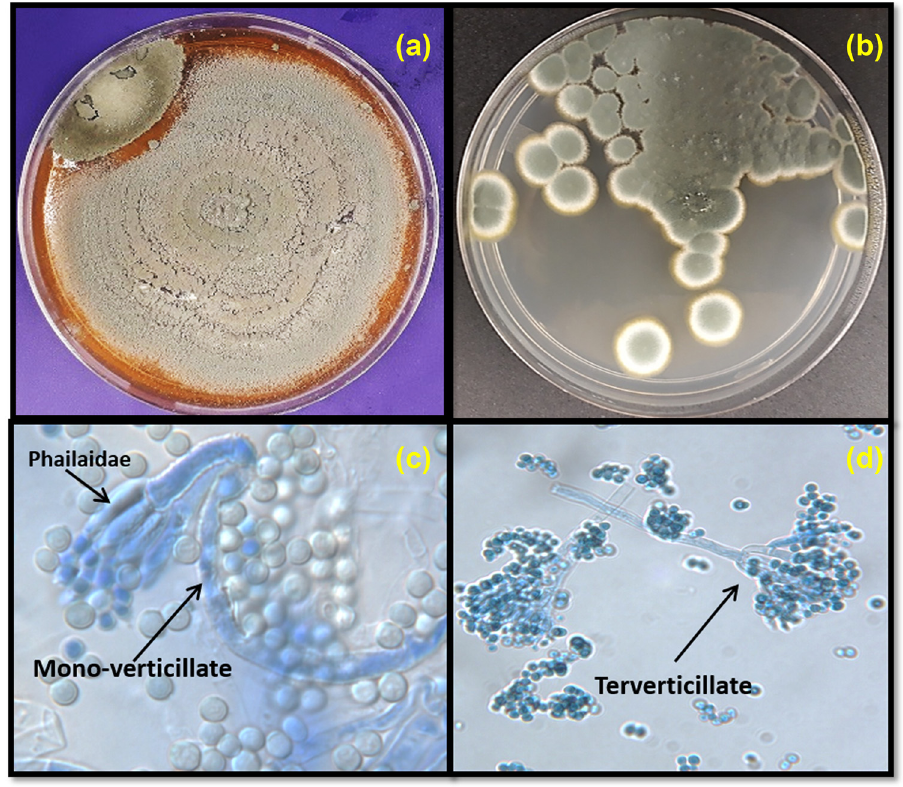
Figure 2: ( a – d ) Morphological characteristics of Penicillium spp. ( a and c ) Bluish - green colony colour without white margins along with mono - verticillate conidiophore identi fi ed as Penicillium expansum. ( b and d ) Greyish green colony colour with white margins and tetra - verticillate conidiophore identi fi ed as Penicillium crustosum.